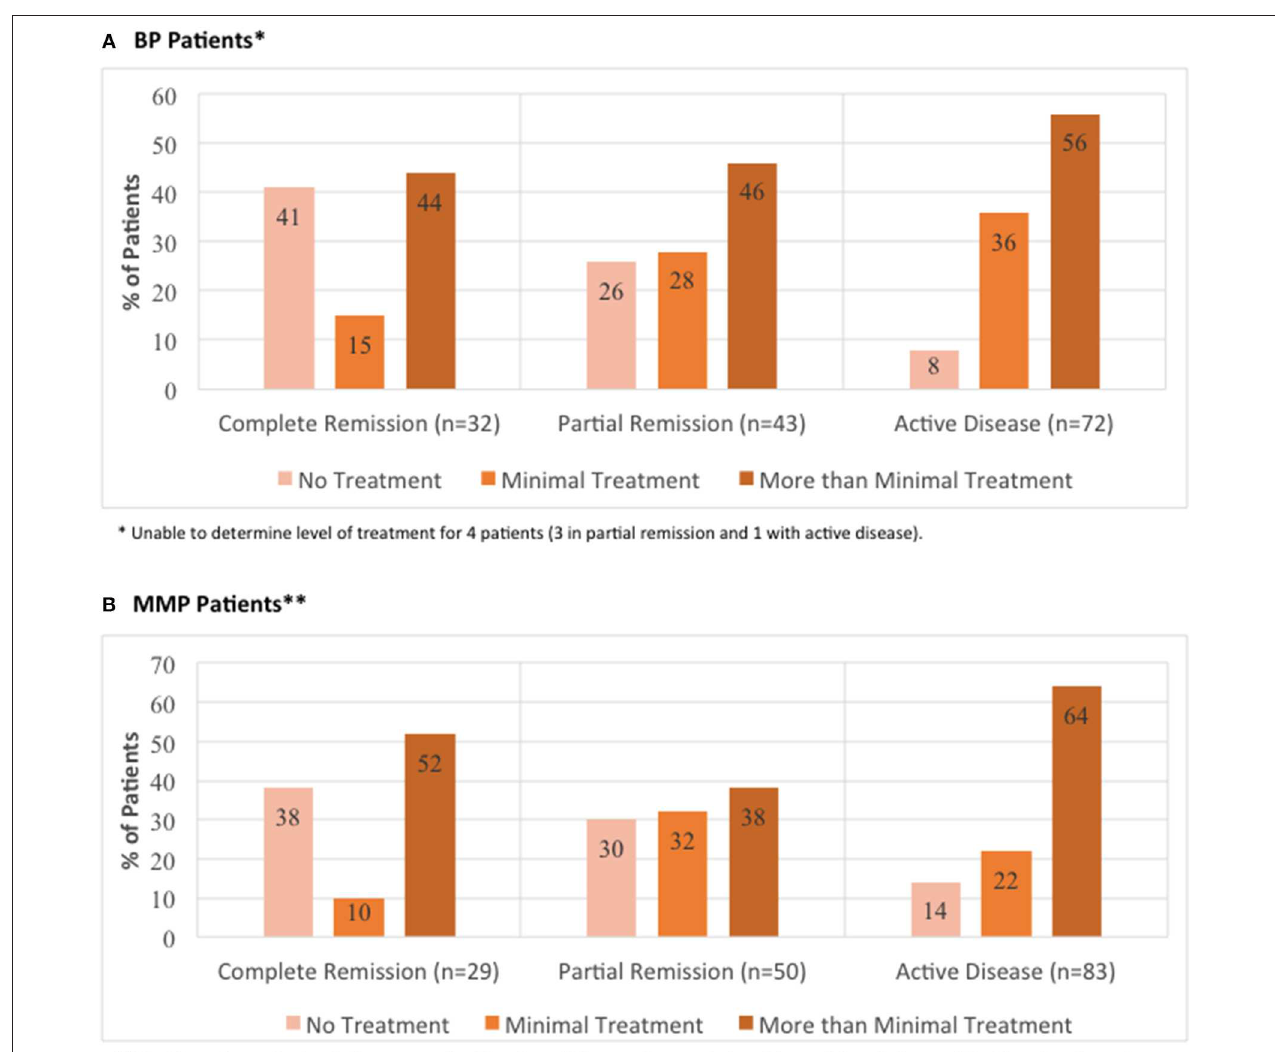
FIGURE 5 | Distribution of level of treatment by global illness activity. BP patients (A) and MMP patients (B) from the IPPF registry were categorized into different groups of global illness activity consisting of either complete remission, partial remission, or active disease. For each group of global illness activity, level of treatment classified as either no treatment, minimal treatment, or more than minimal treatment was